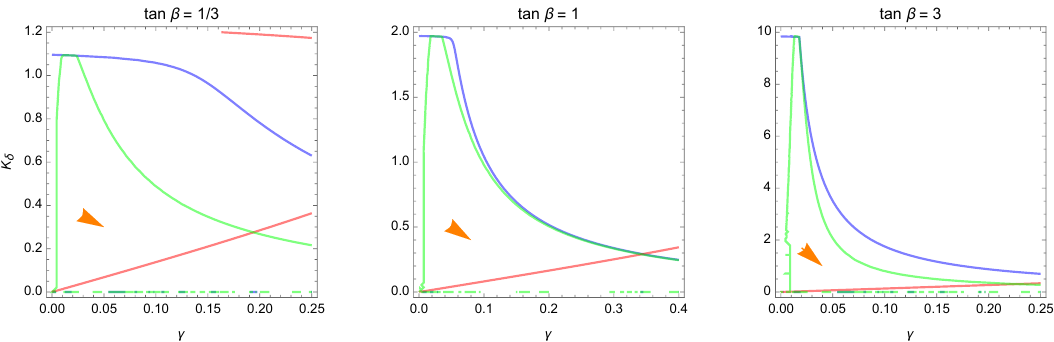
Figure 4 . The allowed parameter space for (cid:28) = 0 : 1 and C g = 1 = 3 C t is indicated by the orange arrowhead. The blue, green and red contours indicate where the neutral scalars, pseudo-scalars and charged scalars respectively develop a tachyonic spectrum. Below the red line, the theory will fall to a charge-violating